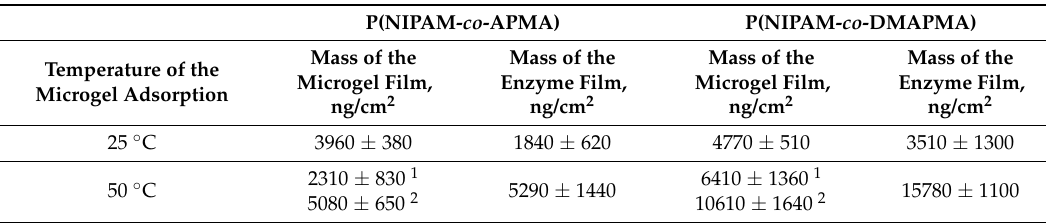
Table 1. Modeled masses of the microgel and microgel/enzyme films at various conditions of their